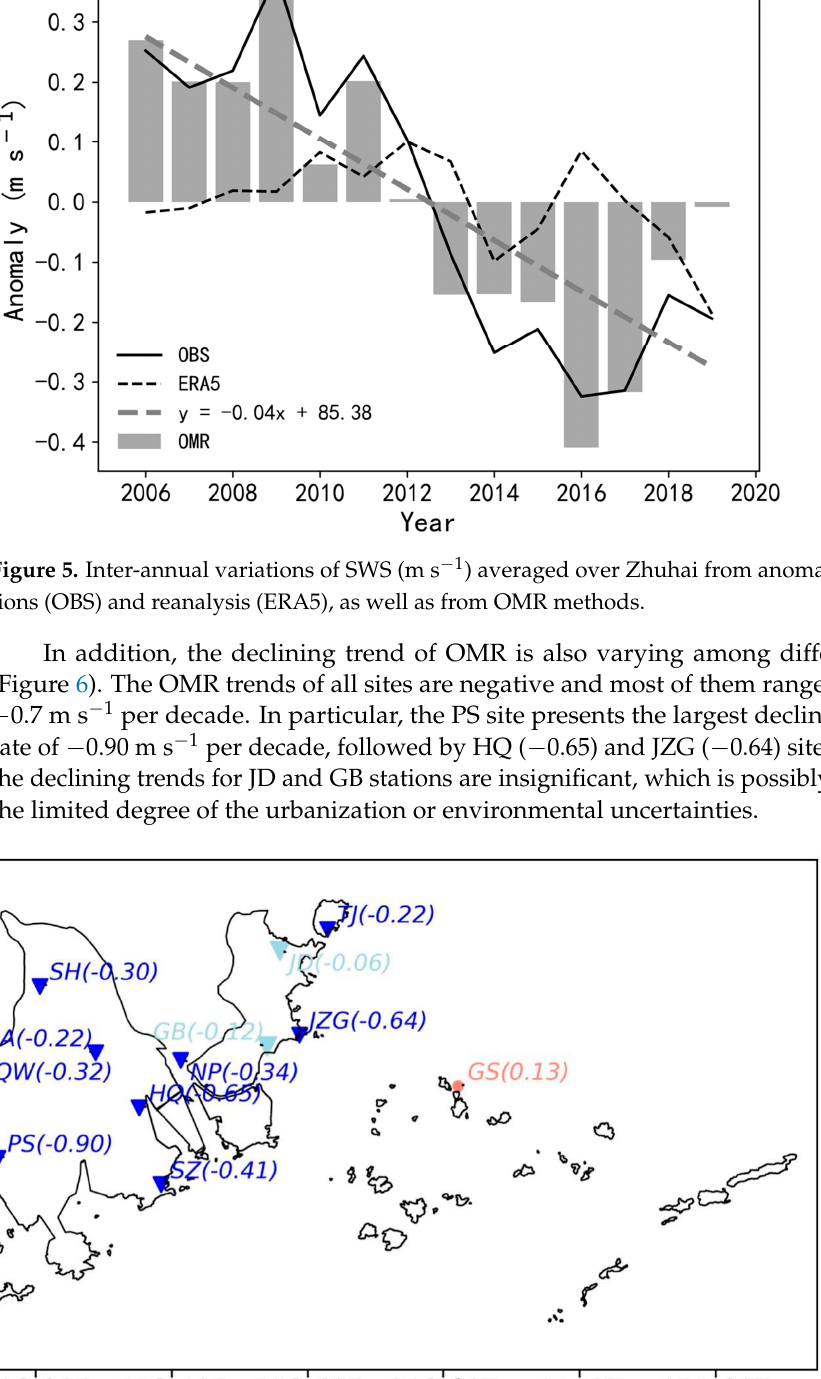
Figure 6. Geographic distribution of the decadal trend (m s − 1 per decade, in brackets) of monthly OMR over Zhuhai.